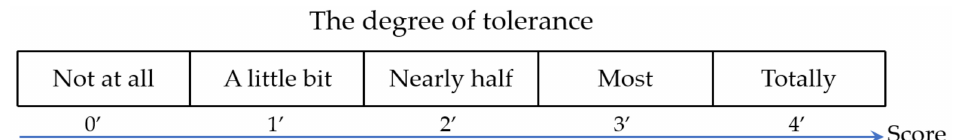
Figure 3. The scoring criteria of the degree of tolerance for click stimuli and chirp stimuli in the evoked